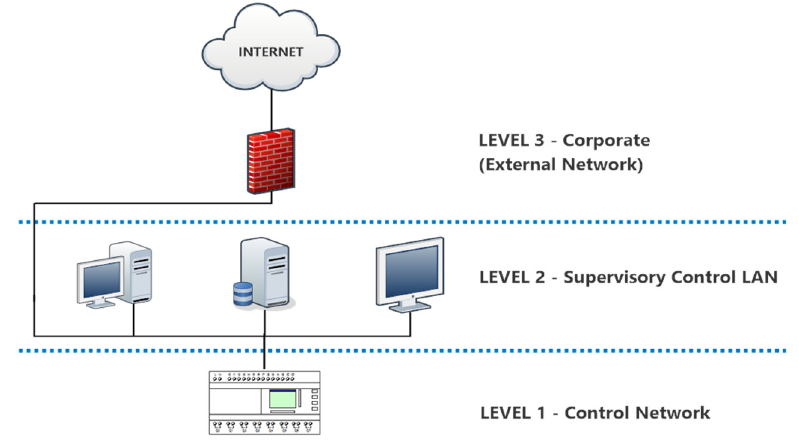
Figure 3. The SCADA system.